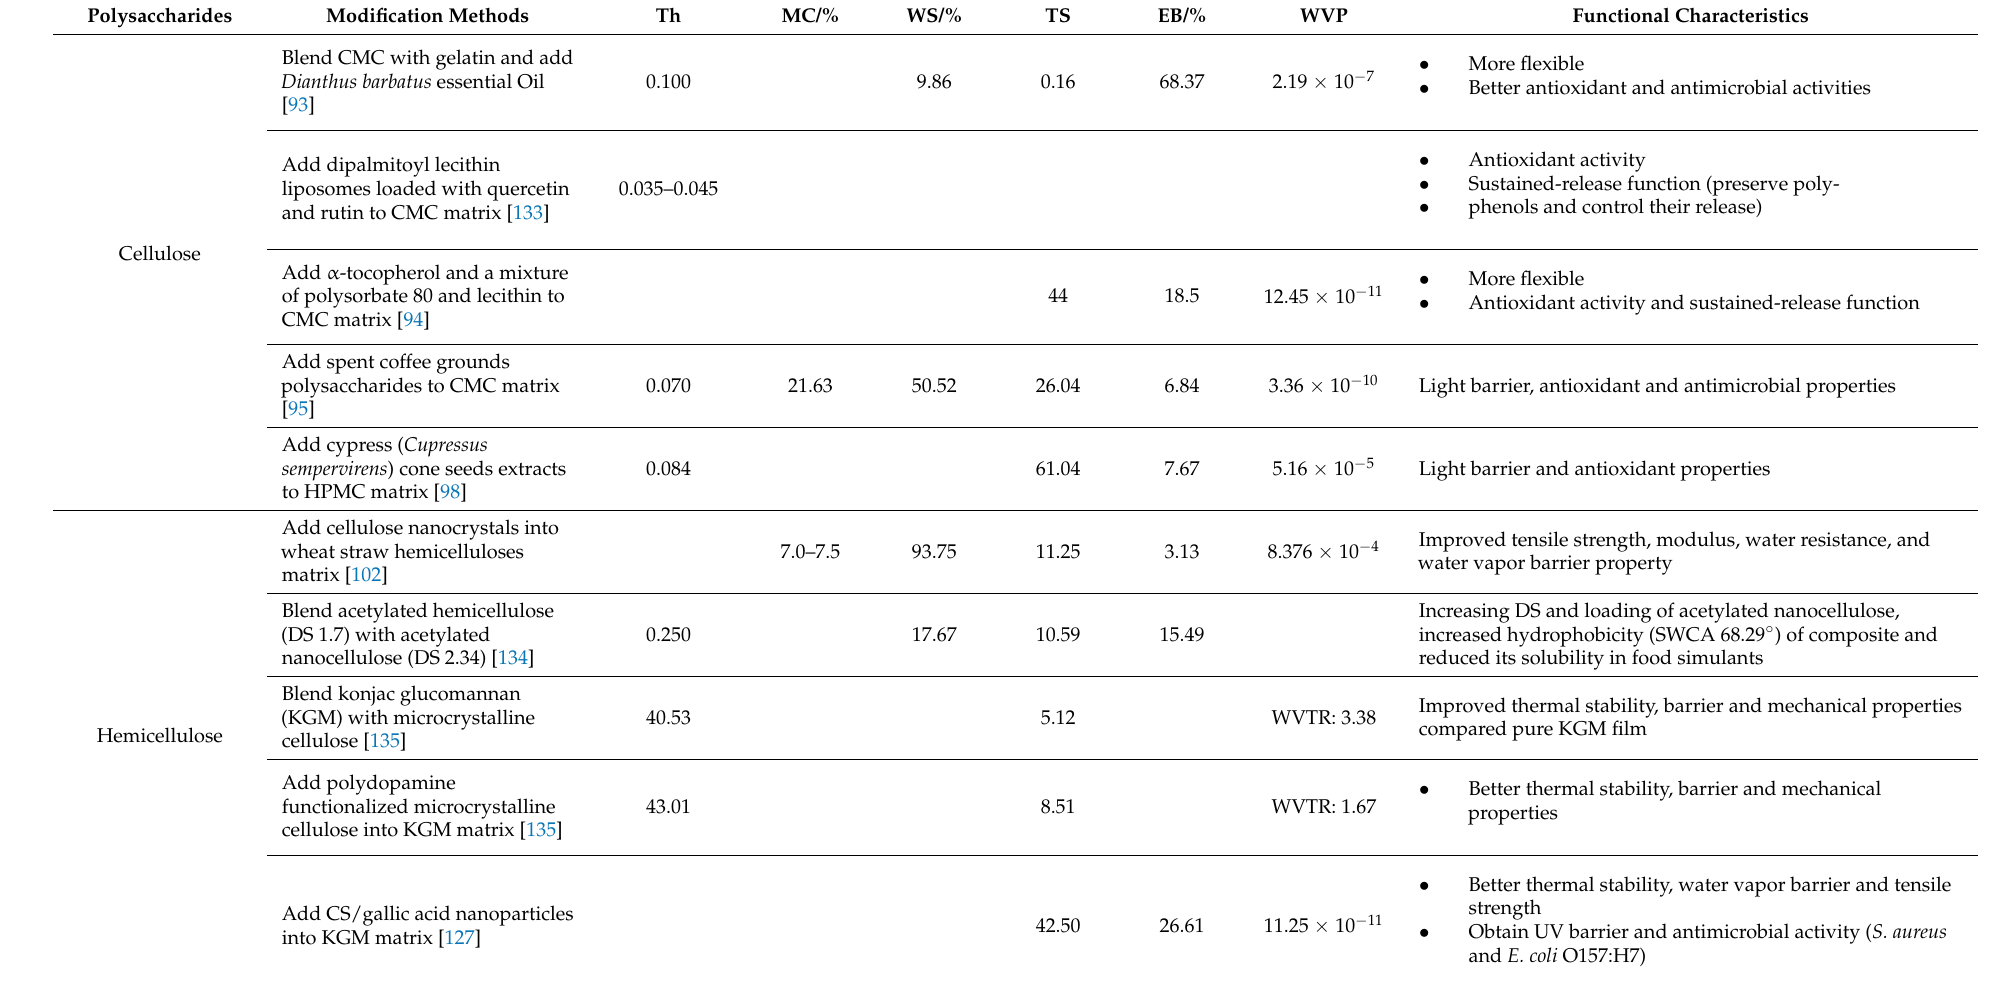
Table 3. Physical modification methods and effects of various